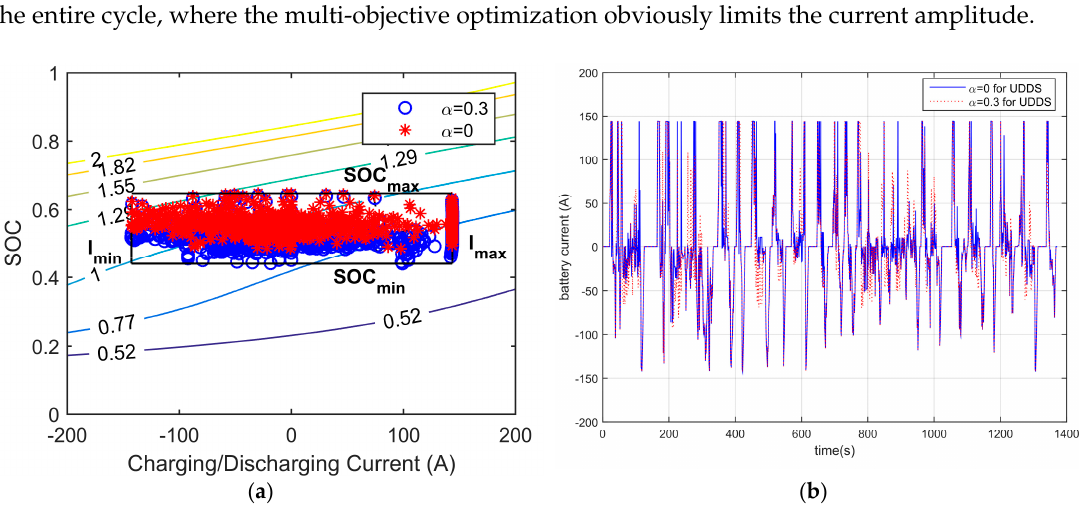
Figure 10. ( a ) ( I batt , SOC ) distribution of the anode-side SEI film growth map with α = 0 and α = 0.3; and ( b ) battery current over the UDDS cycle with different weighting factors of α = 0 and α =